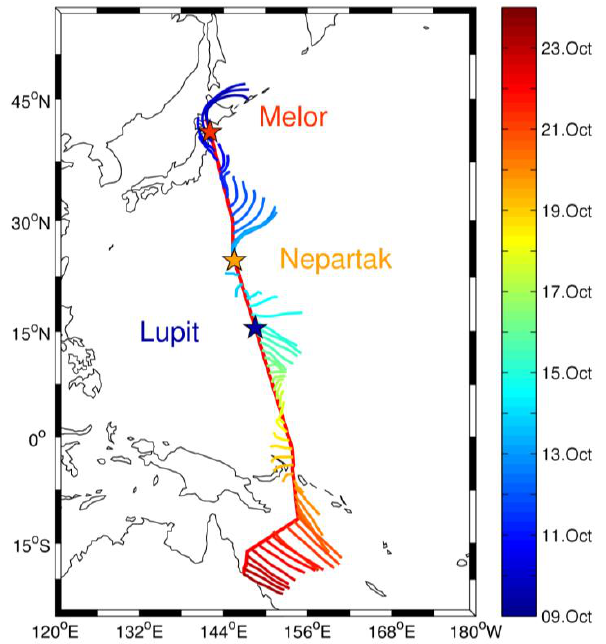
Fig. 1. TransBrom cruise track from Japan to Australia in Octo- ber 2009. Coloured lines indicate one-day back trajectories for each day shown in the colour bar. Dots on the cruise track indicate the three storm events that occurred during the